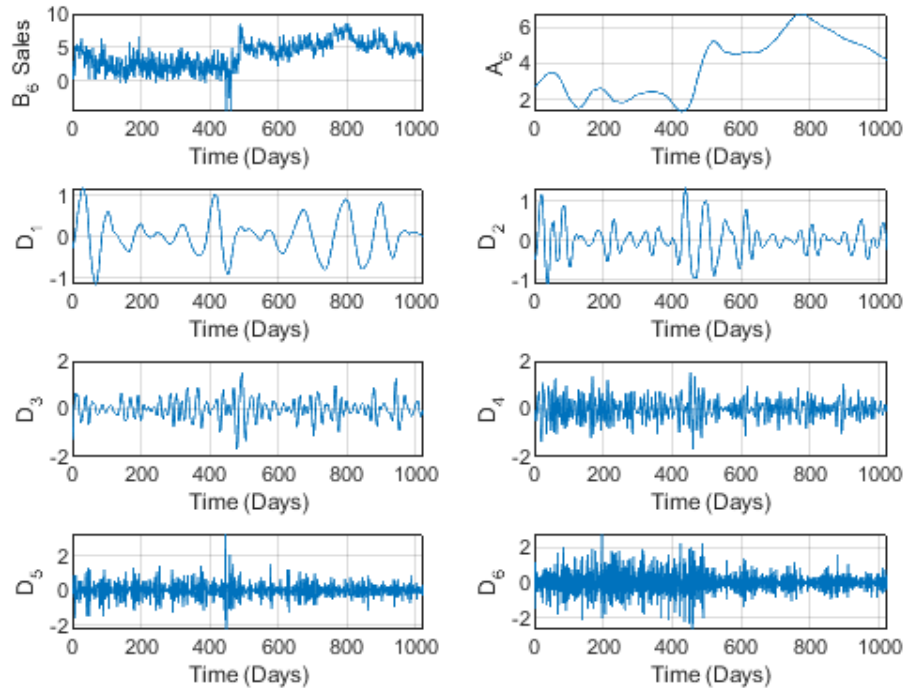
Figure 12. The wavelet decomposition of the Al Aseel brand B 6 sales at level 6.